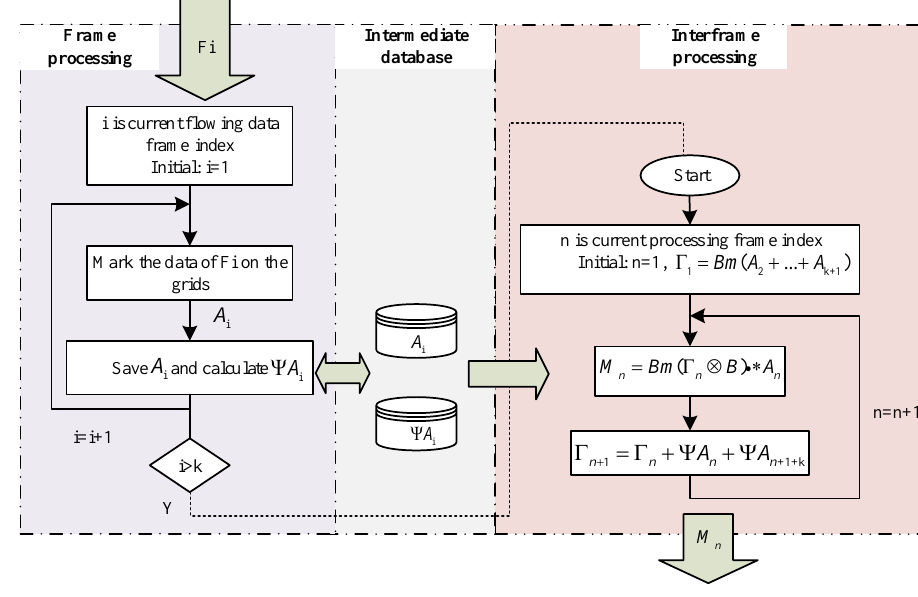
Figure 6. The flow chart of the clutter separation algorithm.